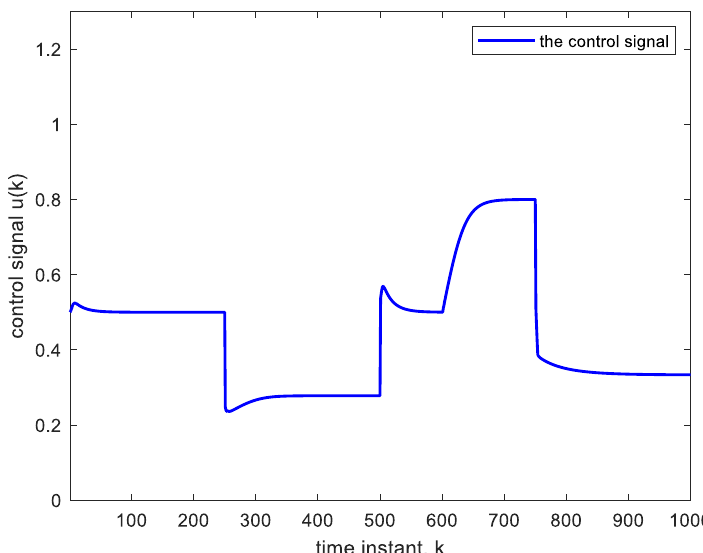
Figure 11. Control signal corresponding to Figure 10.